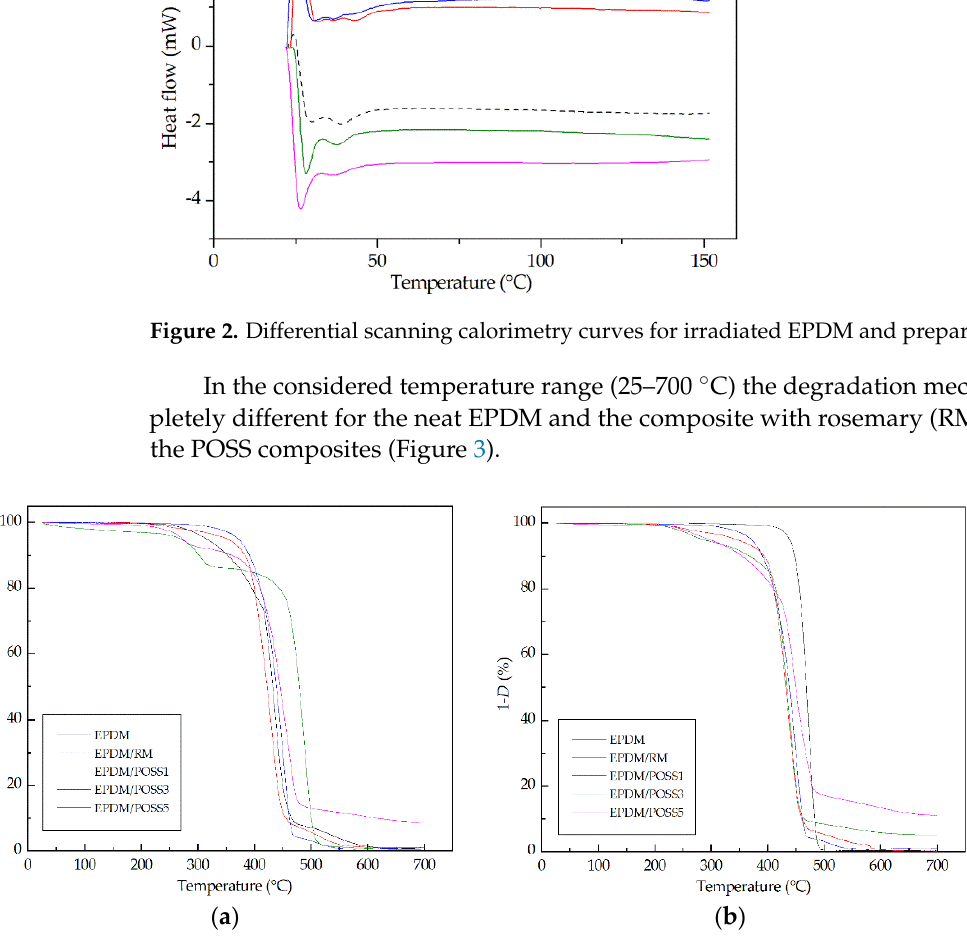
Figure 3. Thermogravimetric curves for the EPDM formulations. ( a ) unirradiated samples; ( b ) the samples subjected to a γ -dose of 50 kGy.